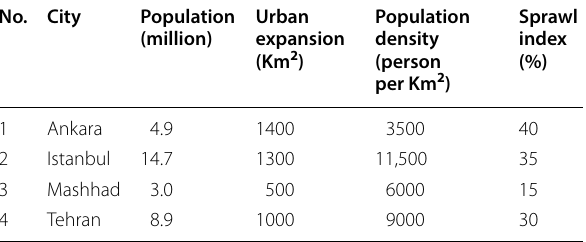
Table 5 Mean annual values of urban independent indicators in